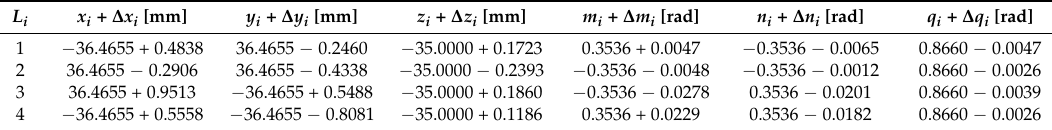
Table 6. The nominal sensor parameters and estimated sensor parameter errors using EKF algorithm.